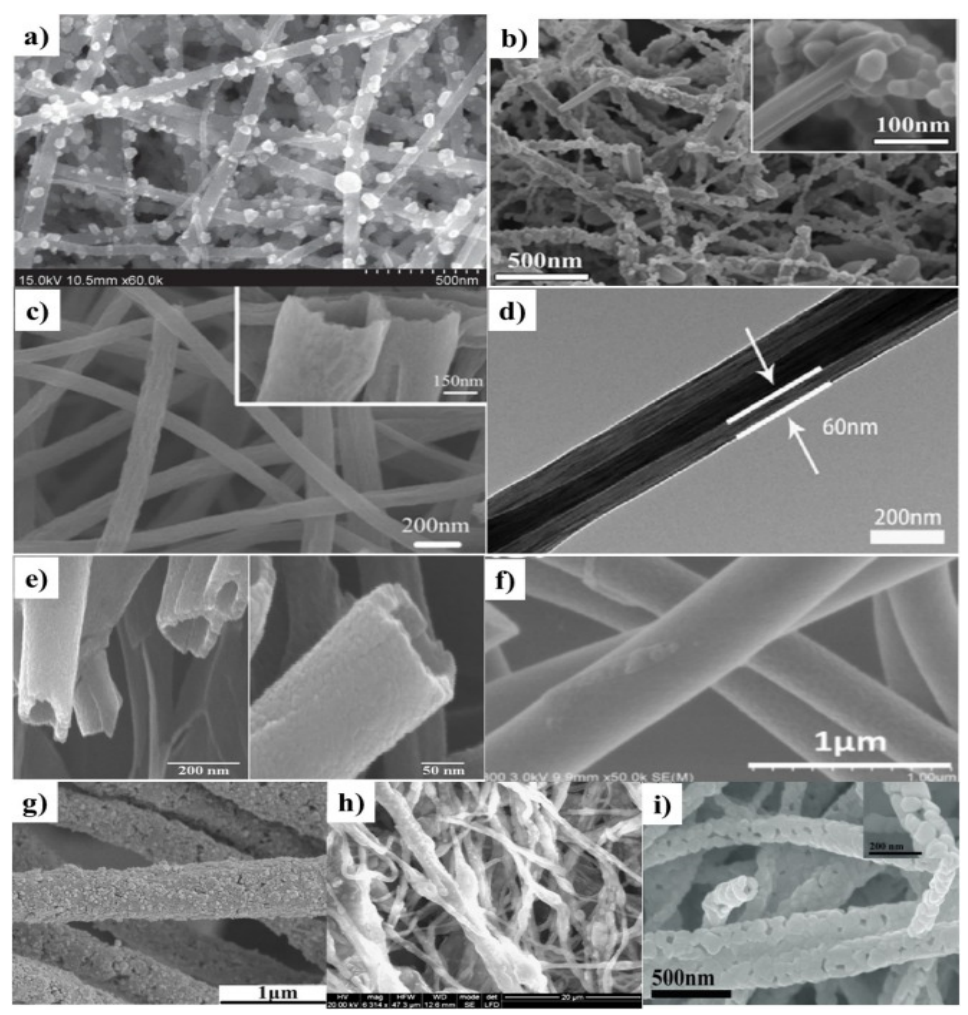
Figure 11. SEM images of electrospun fibers of: ( a ) CdS/TiO 2 on PVP; ( b ) V 2 O 5 /TiO 2 on PVP; ( c ) Ag-TiO 2 nanotubes on PVP; ( d ) core-sheath TiO 2 -SiO 2 on PVA; ( e ) hollow TiO 2 on PVP; ( f ) SiO 2 -TiO 2 calcined at 700 °C; ( g ) TiO 2 on PMMA; ( h ) TiO 2 on PAN; ( i ) Graphene oxide wrapped TiO 2 on PVP adapted with permission from [123].